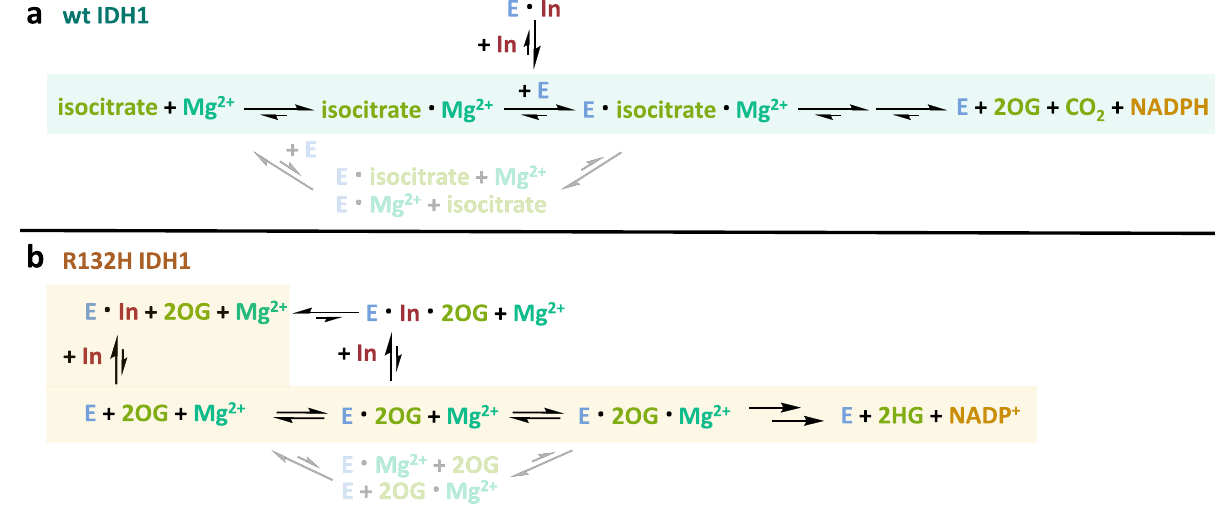
Fig. 7 Summary of kinetic proposals for the formation of catalytically productive wt and R132H IDH1 metal ion – substrate complexes and for the selective allosteric inhibition of R132H IDH1. a Catalysis by wt IDH1. The preferred reaction pathway involving binding of the isocitrate – Mg 2 + complex to E is shaded. E = wt IDH1, which ultimately must be loaded with one NADP + to satisfy the observed half-site reactivity 23 . Note the precise timings/ mechanisms of NADP(H) binding/release during catalysis are not fully established, although the inhibitors can bind to the dimeric form of wt IDH1 with two NADPHs bound. Isocitrate – Mg 2 + binding to wt IDH1 promotes the release of one NADPH from the as-puri fi ed two NADPH bound wt IDH1 to form a closed active state 23 . b Catalysis and inhibition of R132H IDH1. The likely preferred pathways for a reaction involving separate binding of 2OG and Mg 2 + (since 2OG and Mg 2 + interact only weakly) and for inhibition of R132H IDH1 are shaded. The allosteric inhibitors bind preferentially to the two NADPH- bound forms of R132H IDH1, which is an open inactive state 23 ; they thus bias IDH1 into an inactive conformation. Note, the binding of Mg 2 + and 2OG to R132H IDH1 is weaker than that of the isocitrate – Mg 2 + complex to wt IDH1. E = R132H IDH1 loaded with (at least) one NADPH. In = allosteric IDH1